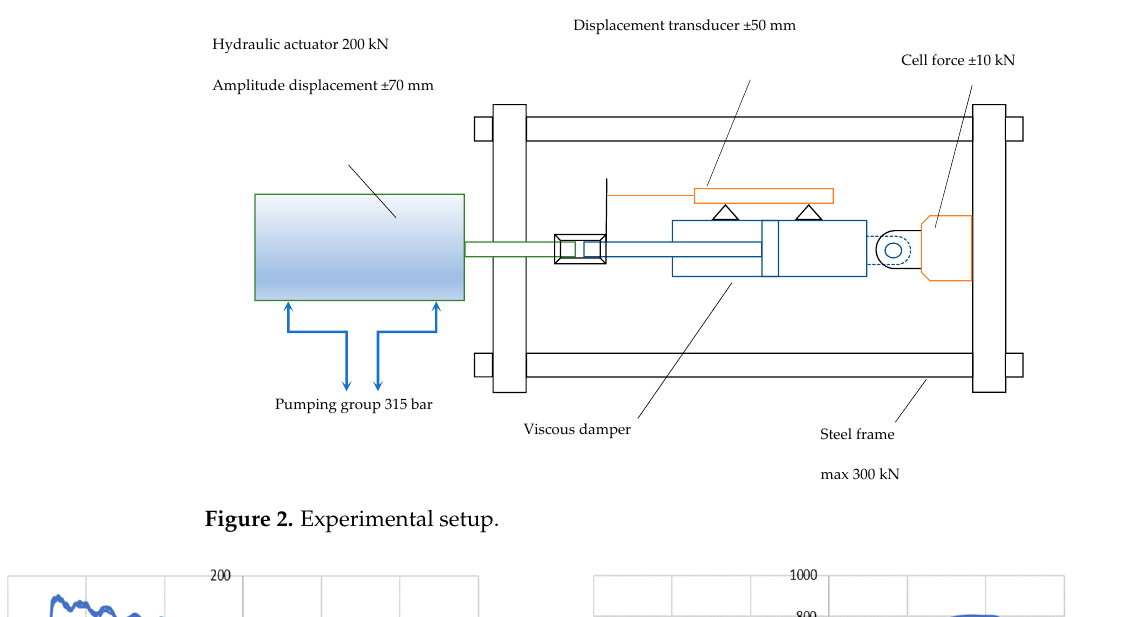
Figure 2. Experimental setup.